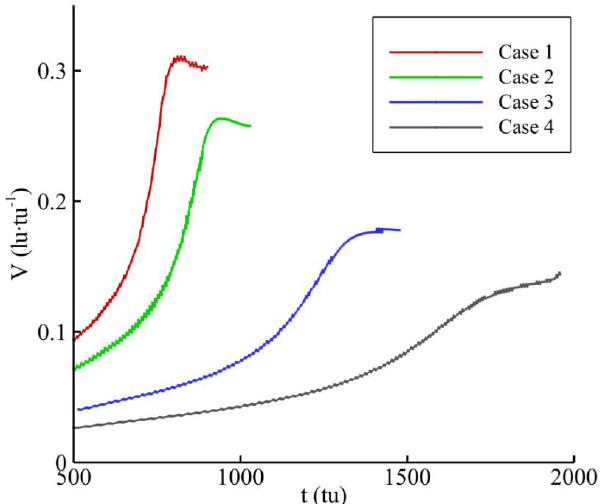
Figure 9. The evolution of micro-jet in Cases 1–4.